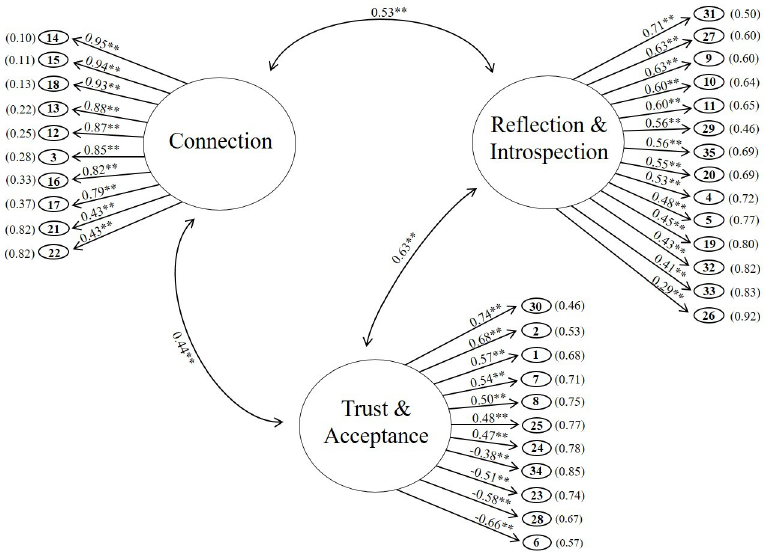
Fig 2. Path diagram of the three-factor, 35-item NIH-HEALS measure. Data are standardized coefficients from mean and covariance structure model of confirmatory factor analysis. The numbers in the ovals represent the NIH-HEALS items. Data in parenthesis following items are standardized error coefficients. �� p <